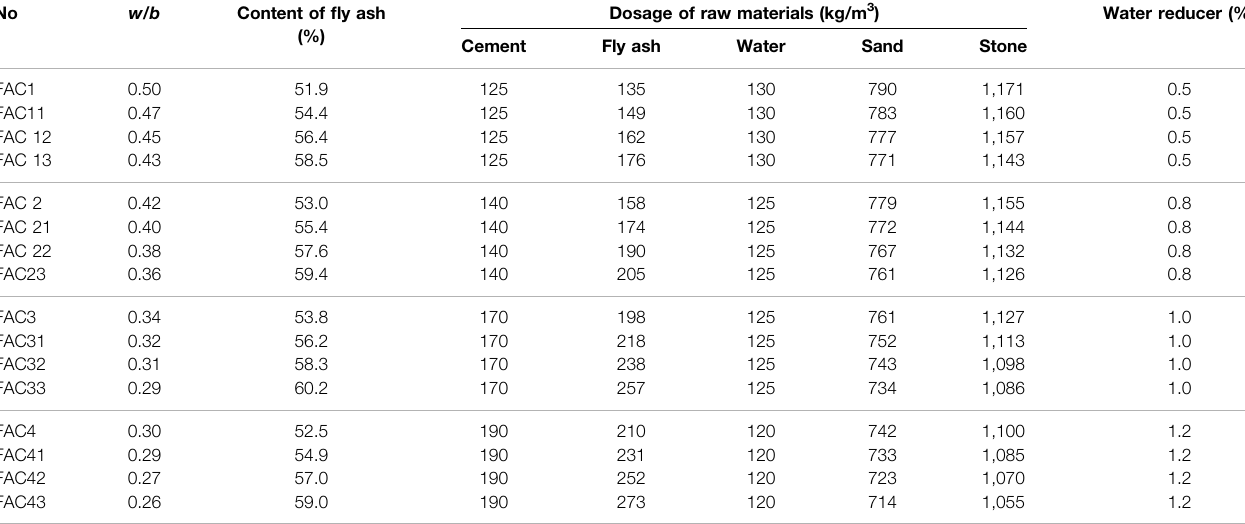
TABLE 4 | Mix proportion of FAC.